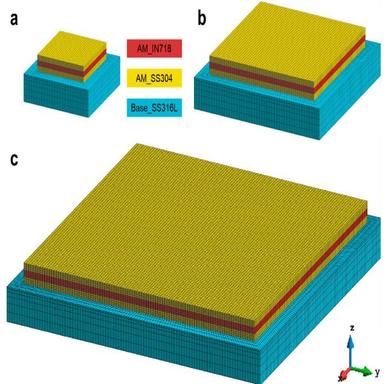
FE mesh models of three square-bulks with different dimensions: (a) 5 × 5 × 1.2 mm3 ; (b) 10 × 10 × 1.2 mm3 ; (c) 20 × 20 × 1.2 mm3 . For the 20 × 20 × 1.2 mm3 MMS, 90◦ rotation and island scanning strategies were used.